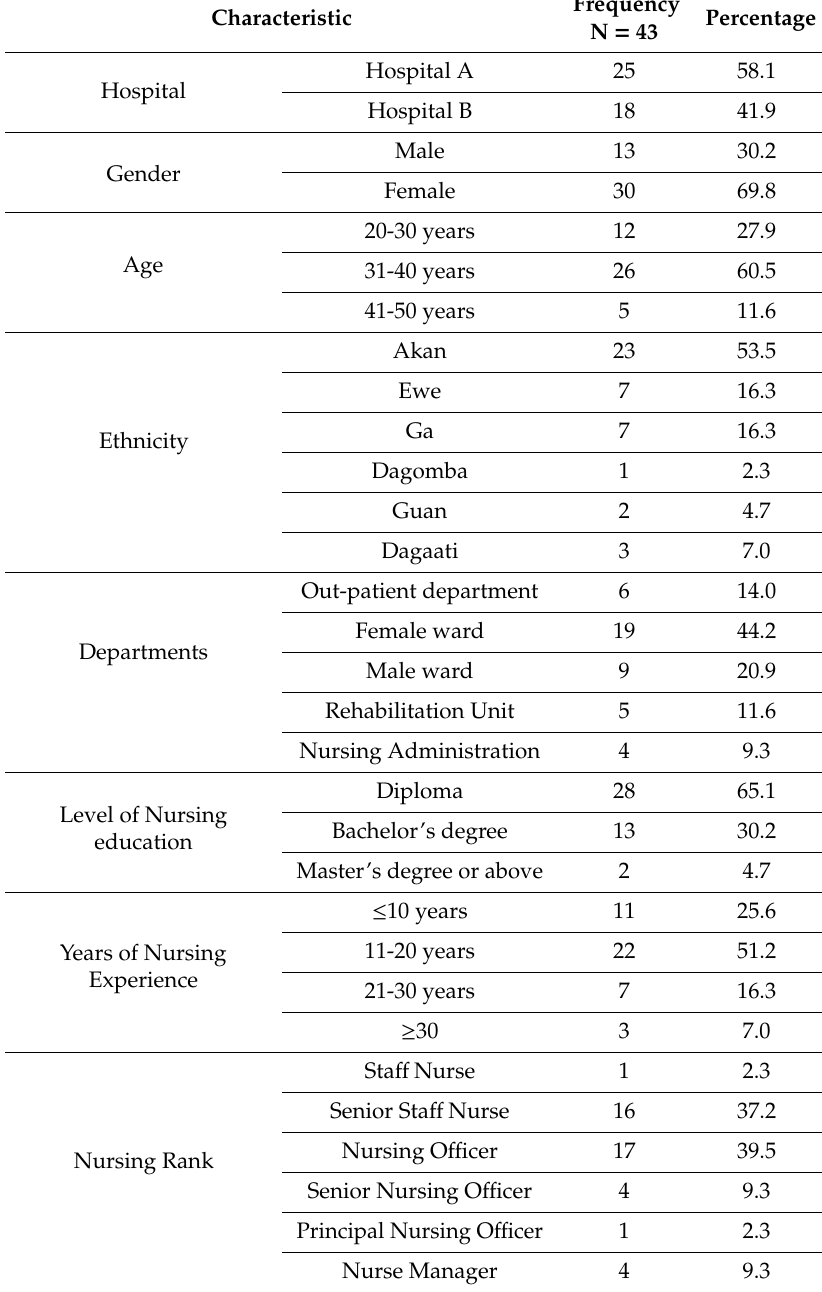
Table 1. Characteristics of the mental health nurses involved in the study.